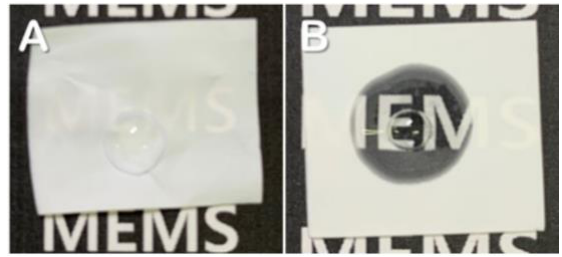
Figure 1. Wettability test of the Nafion TM dispersion on pristine ( A ) and GA/#3_60-treated PTFE porous substrates ( B ).